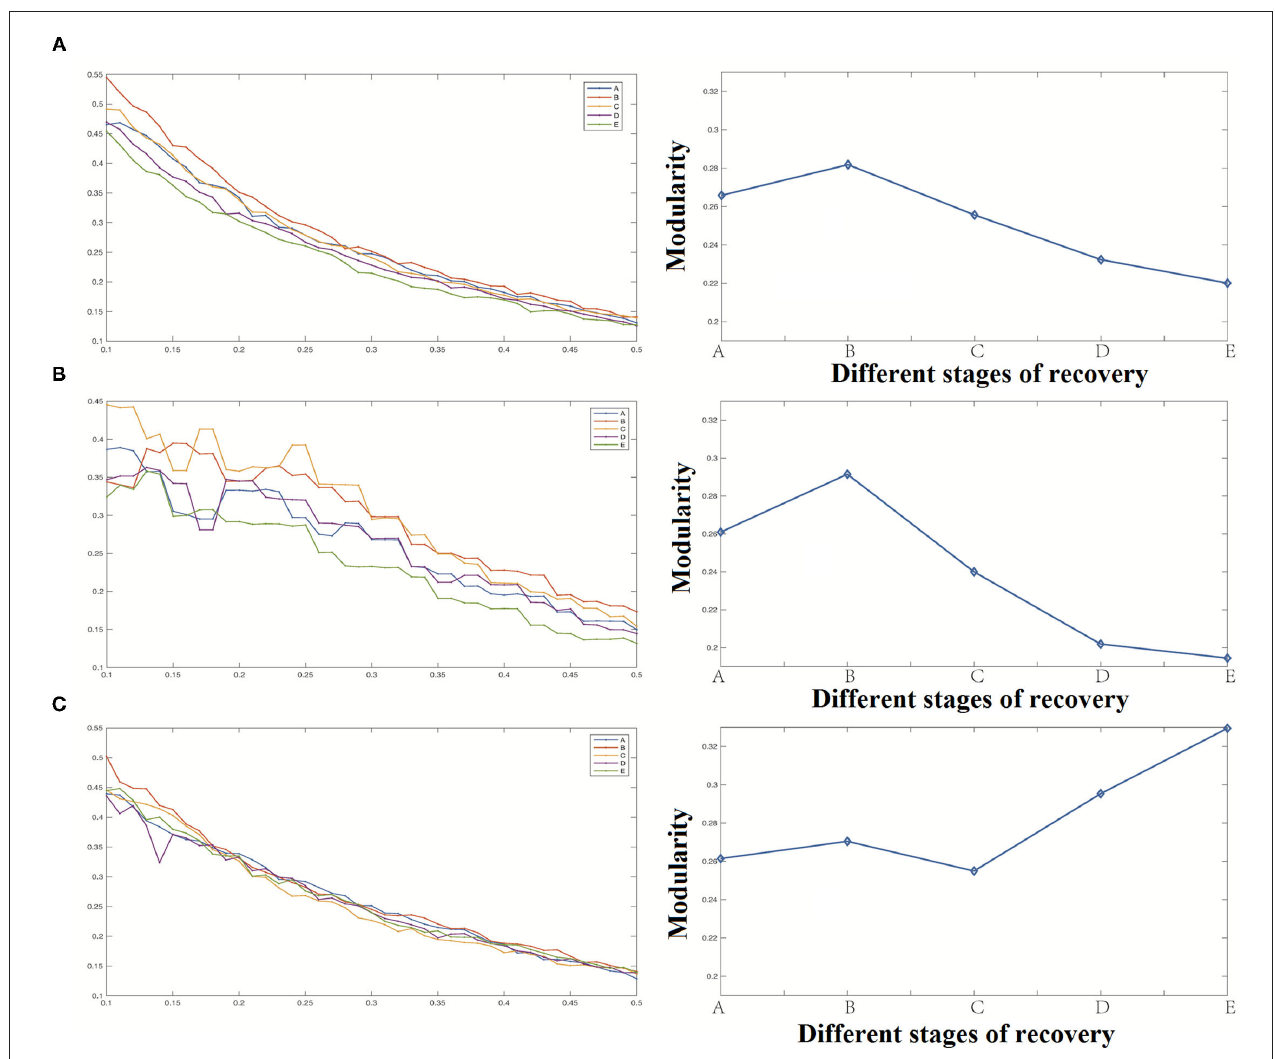
FIGURE 9 | Modularity analysis results [ (A) Modularity of the whole network, (B) Modularity of cortical region, (C) Modularity of deep region].